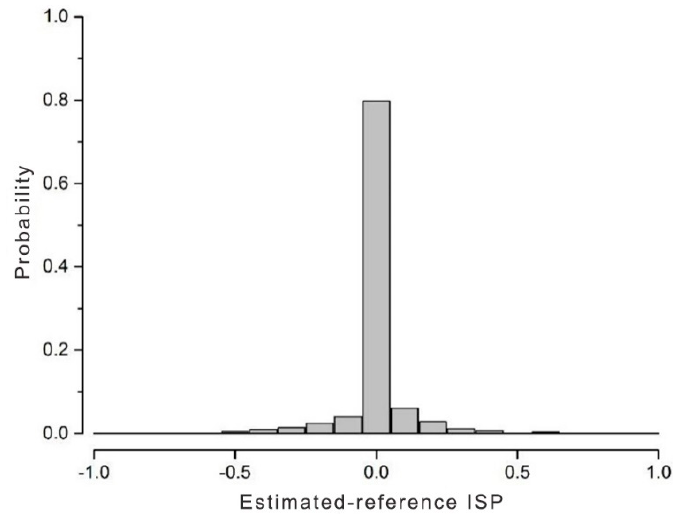
Figure 5. Distribution of error between ISP estimations and independent validation samples from 2014 to 2017.